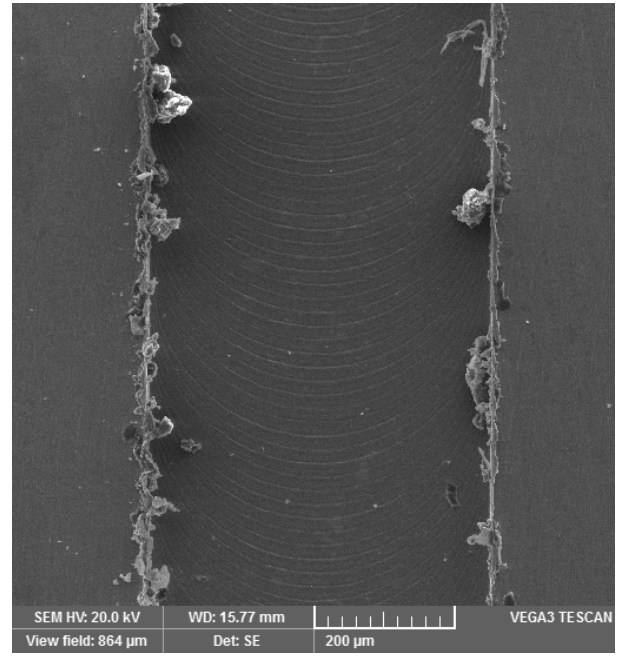
Figure 10. Maximum top burr width ( f z = 8µmtooth − 1 , V c = 5mmin − 1 , a p =